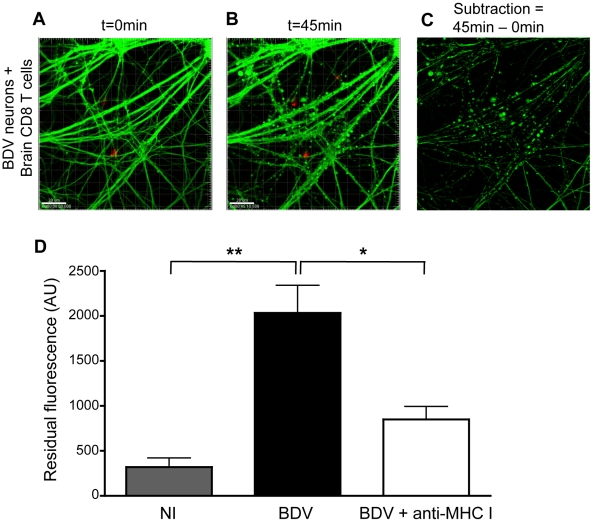
Interaction with brain-purified CD8 T cells induces early morphological changes of BDV-infected neurons.(A) A representative BDV-infected neuronal network loaded with calcein AM (green) at the start (t = 0 min) and (B) 45 min after coculture with PKH-26 stained brain-derived CD8 T cells. (C) Representative example of the image analysis performed to quantify the formation of calcein beading figures. Upon subtraction between images shown in (A) and (B), the residual fluorescence signal corresponds to calcein beading. (D) Quantification of the differences in fluorescence values, expressed as arbitrary units (AU). Values are expressed as means±sem of 5 to 6 independent experiments. *, p<0.05; **, p<0.01 by Mann-Whitney U-test.